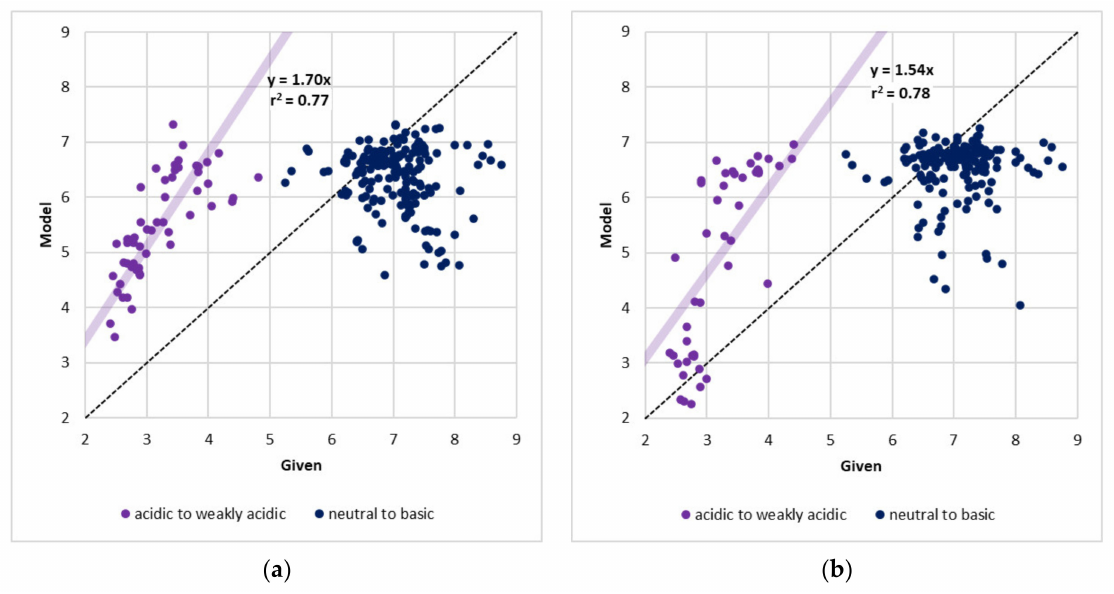
Figure 21. Plot of given and modelled pH values based on Sentinel-2 ( a ) Level-1C TOA and ( b ) Level-2A BOA products.